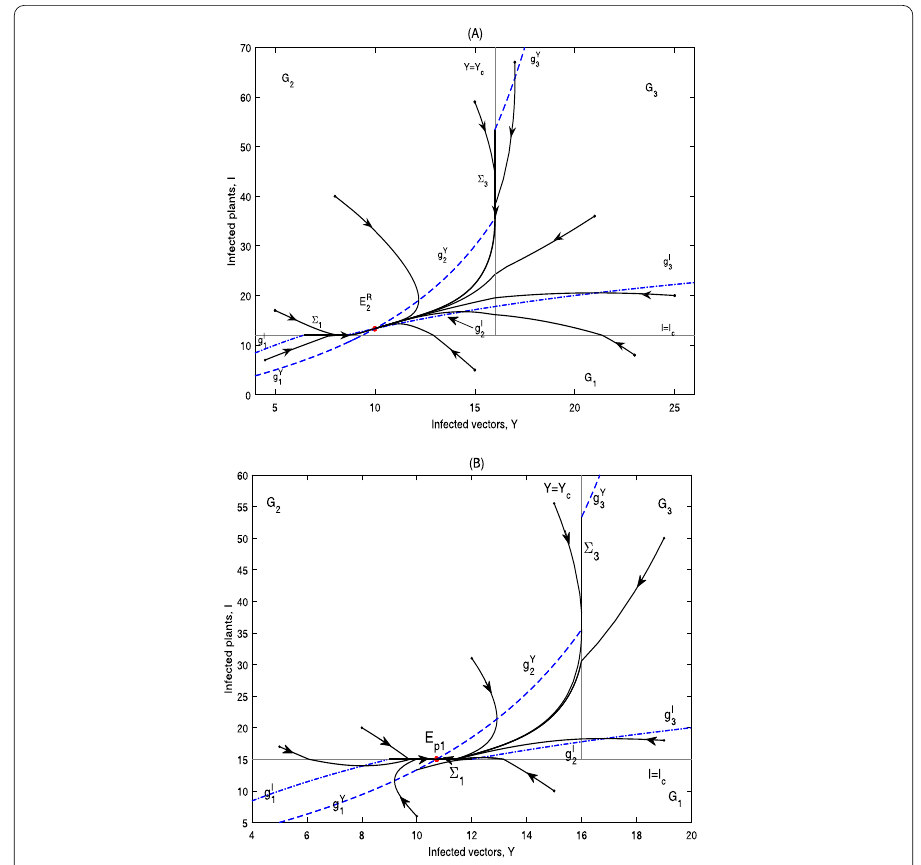
Figure 13 Global dynamics in Case D.11. ( A ) E R 2 is globally asymptotically stable. Y c = 16, I c = 12. ( B ) E p 1 is globally asymptotically stable. Y c = 16, I c =